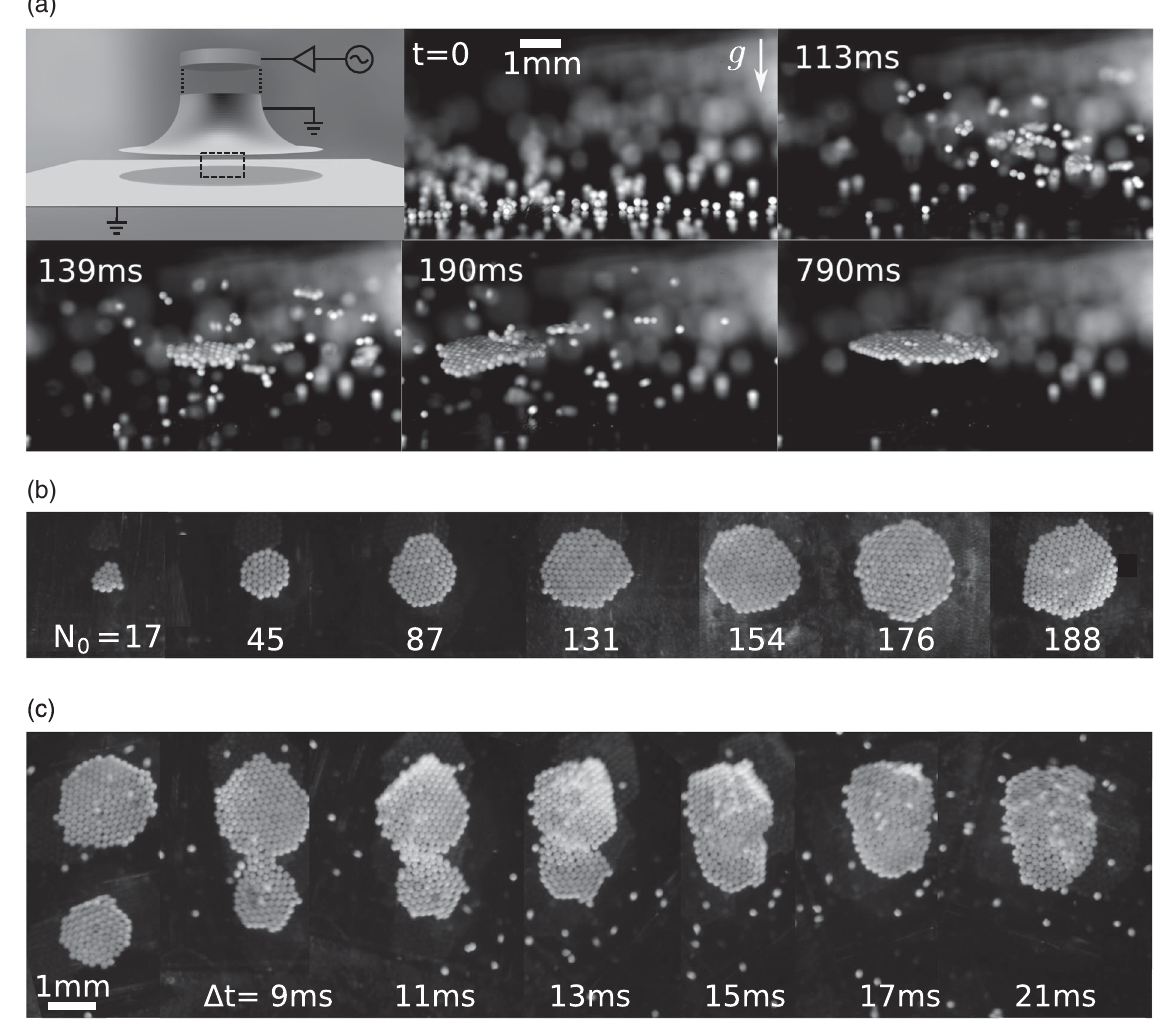
FIG. 1. Self-assembly of granular rafts by acoustic levitation. (a) Three-dimensional drawing of setup and sequence of images (side view) showing the self-assembly of a granular raft from its constituent particles. Piezoelectric elements (cylinder) are attached to an aluminium horn to generate ultrasound (only the base is shown). The grounded aluminium horn is spaced over a (grounded) indium-tin- oxide glass slide. The dashed black rectangle indicates the field of view in the subsequent still images. At t ¼ 0 , a standing wave is established between the transducer (above the top of the image) and reflector surface, which is covered with loose particles. These particles are picked up from the reflector surface by the primary acoustic force and initially form small clusters, which travel in the underdamped acoustic environment until they coalesce to form a monolayer. (b) Self-assembled rafts composed of varying numbers of particles N 0 , viewed from below. (c) Sequence of images from below, showing two rafts approaching each other and merging into a larger raft. Variations in brightness correspond to local curling of the raft out of